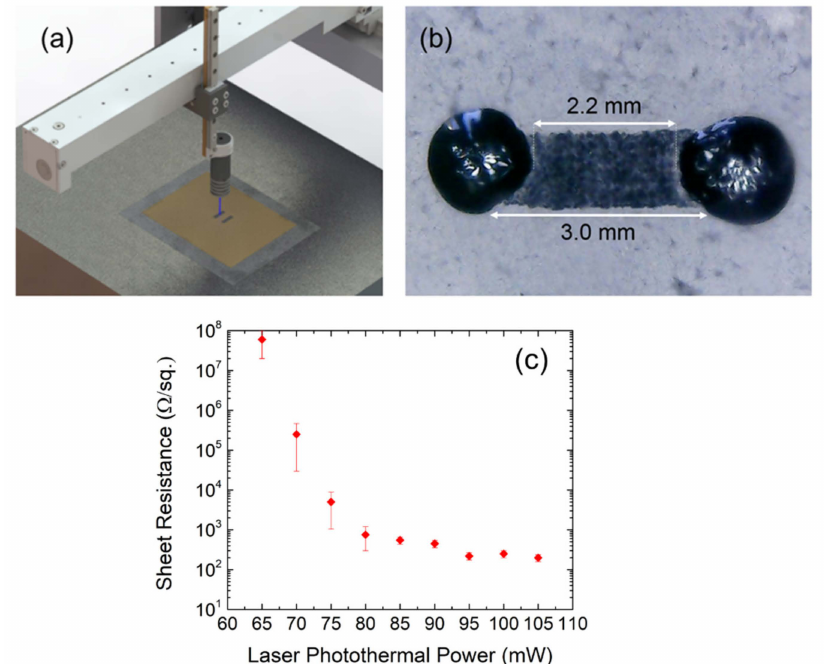
Figure 1. ( a ) Schematic of the CNC-driven laser used for the fabrication of rGO memristors. The spatial resolution of the system used in this work is 10 µ m. ( b ) Actual picture of one of the laser-fabricated memristors (L = 2.2 mm, W = 1 mm) using microdrops of bare conductive electric paint TM as contacting electrodes. ( c ) Sheet resistance of laser-reduced graphene oxide samples (4 mg / mL) on PET treated at di ff erent laser powers ( λ = 405 nm) extracted by the transmission line method (TLM) [27]. Error bars were calculated as the standard deviation of 15 di ff erent samples for each laser